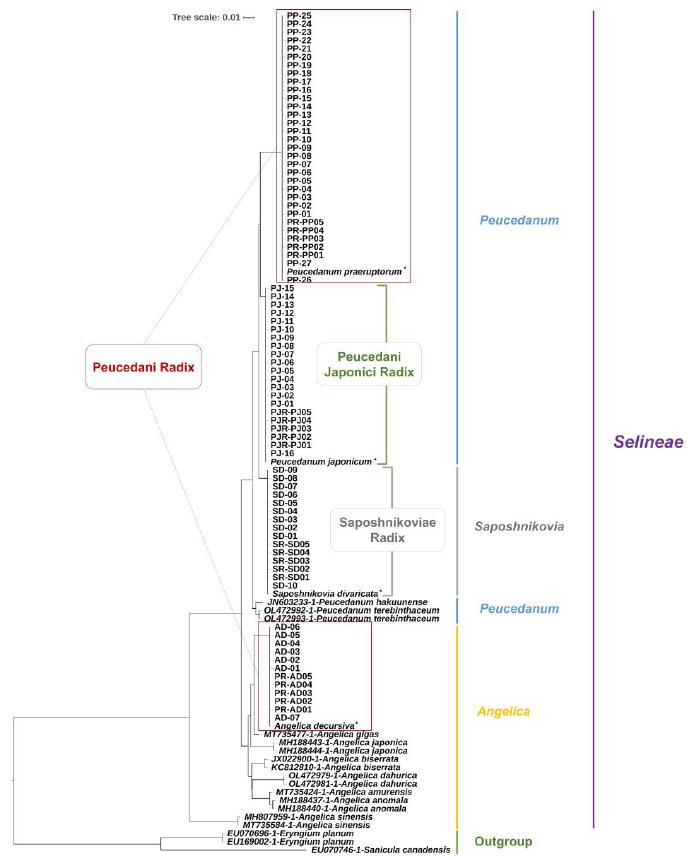
Figure 1. Maximum likelihood-based inference of phylogenetic tree with Smart Model Selection, constructed based on the combined five DNA barcode regions (ITS and four plastids). PJ: Peuceda- num japonicum , PP: P. praeruptorum , AD: Angelica decursiva , SD: Saposhnikovia divaricata. ‘*’ represents the NCBI Genbank data combination.